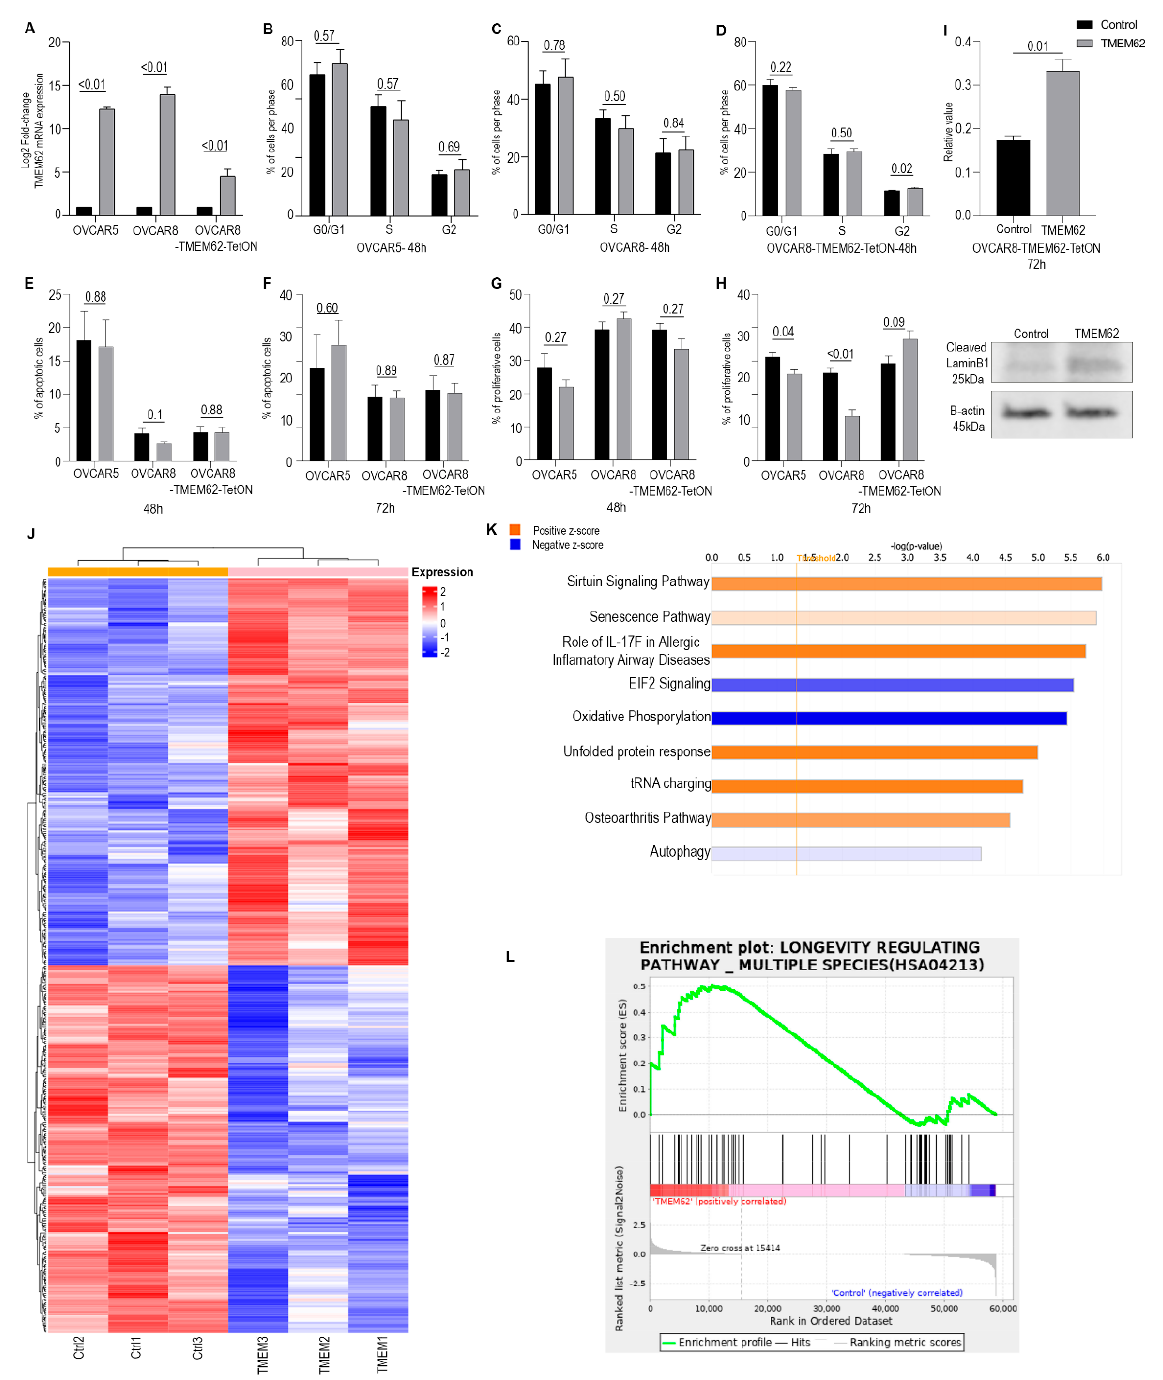
Figure 2. In vitro data for OVCAR5 and OVCAR8 cells with transient overexpression of TMEM62. ( A ) qRT-PCR results from TMEM62 overexpression using a transient method and a dox-inducible model. Functional analysis includes ( B ) cell cycle of OVCAR5 cells, ( C ) OVCAR8, and ( D ) OVCAR8- TMEM62-TetON cells at 72 h; apoptosis assay at ( E ) 48 h, and ( F ) 72 h using OVCAR5, OVCAR8, and OVCAR8-TMEM62-TetON cells, and proliferation assay of the same cells overexpressing TMEM62 at ( G ) 48 h and ( H ) 72 h. ( I ) Senescence measurement of OVCAR8-TMEM62-TetON. Up: Western blot quantification/ Bottom: Western blot image of Cleaved LaminB1 and β -Actin. ( J ) Heatmap of OVCAR8 cells expressing TMEM62. ( K ) Pathway analysis generated from RNASeq using IPA. ( L ) Enrichment plot from RNASeq using KEGG.